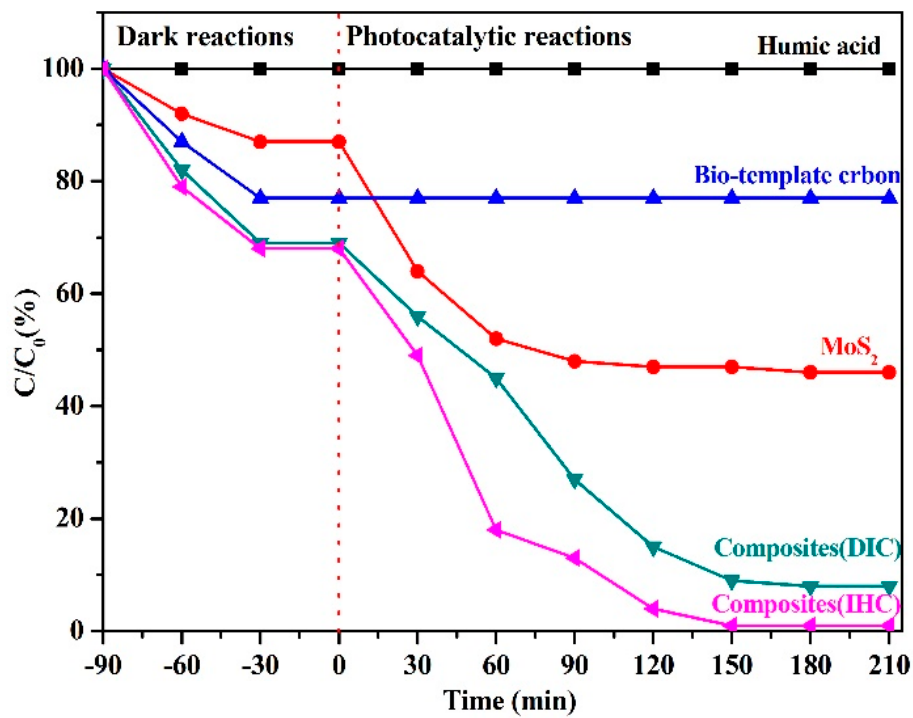
Figure 8. Degradation performance of bio-template carbon, pure MoS 2 , and the composites synthe- sized by two methods for humic acid.